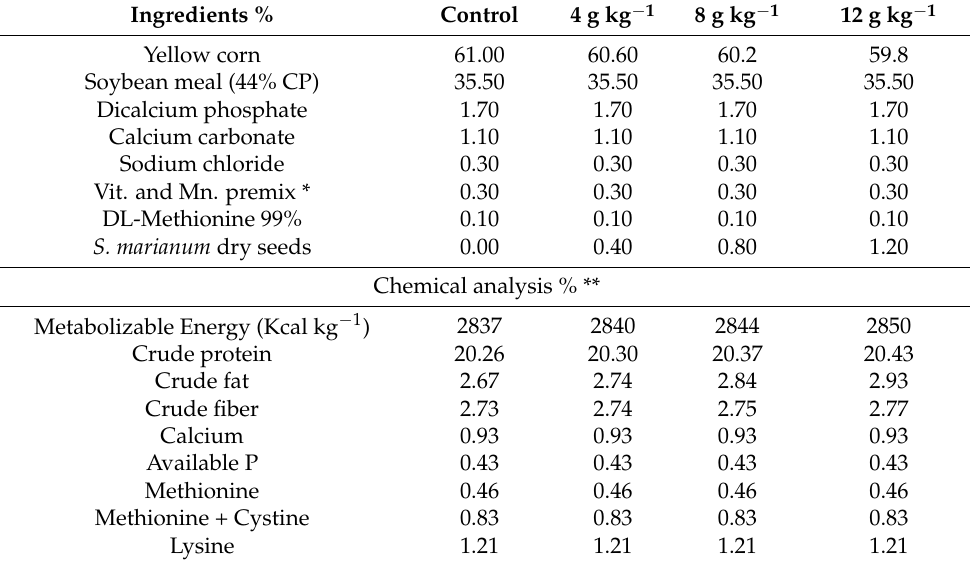
Table 1. Chemical analysis of the experimental diets (g kg − 1